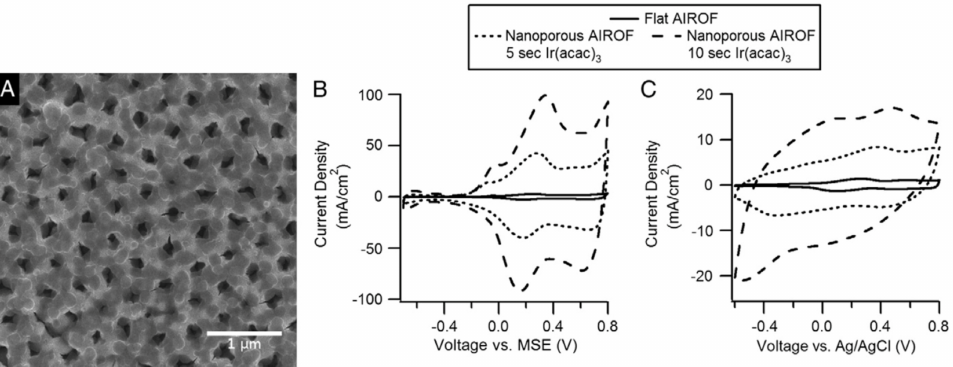
Figure 24. ( A ) SEM image of the top surface of the AAO template following 200 cycles of activation in 0.1 M H 2 SO 4 . ( B ) CV scans in 1 M H 2 SO 4 of flat and nanoporous AIROFs. ( C ) CV scans in phosphate-buffered saline of flat and nanoporous AIROFs, demonstrating the enhancement in CSCc. Reprinted with permission from reference [50]. Copyright 2010 Elsevier